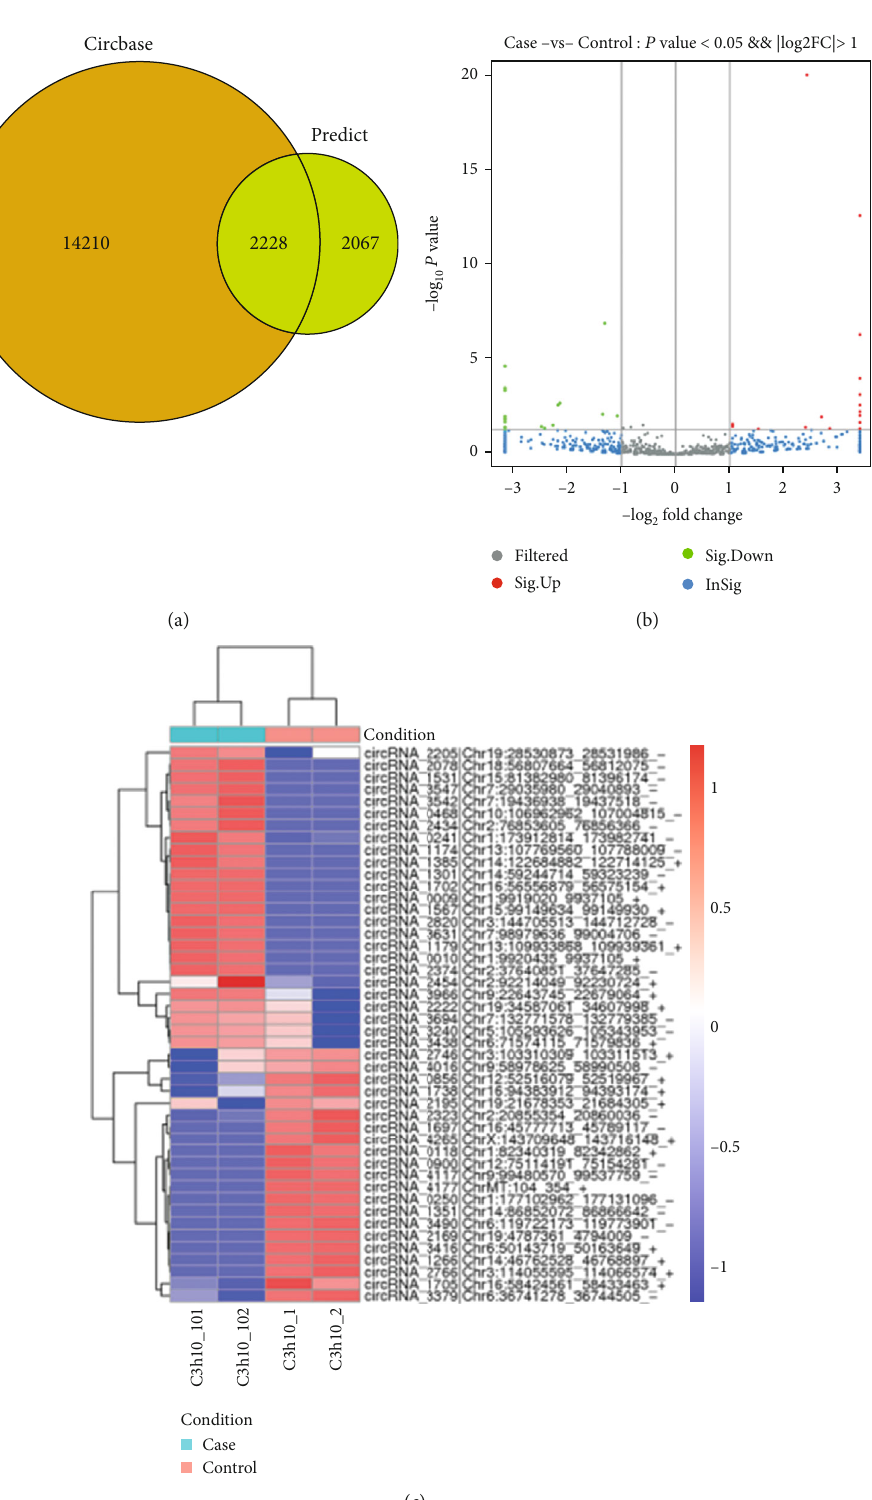
Figure 7: Di ff erential expression of circRNAs between undi ff erentiated and di ff erentiated MSCs (C3h10_1 and C3h10_2: control; C3h10_ 101 and C3h10_102: case). (a) Venn diagram showing the number of expression patterns of circRNAs. (b) Volcano plots of circRNAs. Volcano plots were constructed by fold-change and P values. The vertical lines correspond to P values, and the horizontal lines represent log2 (fold change) up- and downregulation between control versus case samples. The red (up) and green (down) points show the signi fi cantly di ff erentially expressed circRNAs. (c) Hierarchical clustering of circRNAs. Hierarchical clustering analysis of circRNAs that was di ff erentially expressed between control versus case samples ( foldchange > 2 ; ∗ P < 0 : 05